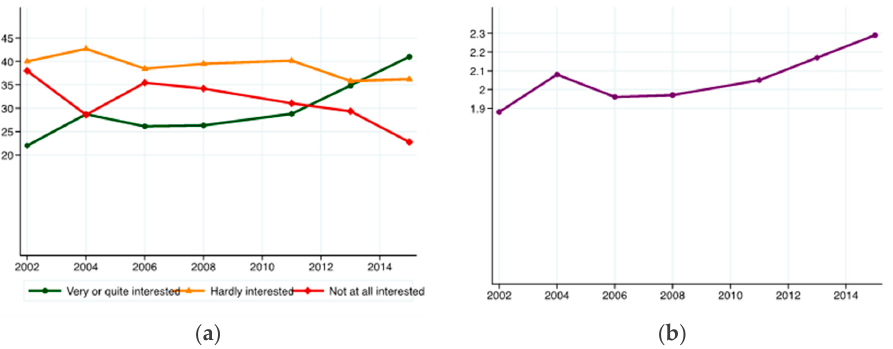
Figure 2. Evolution of political interest and politicization index. ( a ) Interest in politics, measured as the percentage of individuals very or quite interested in politics, hardly interested, or not at all interested; ( b ) politicization Index, which has been built with the following formula: P . I . = p 1